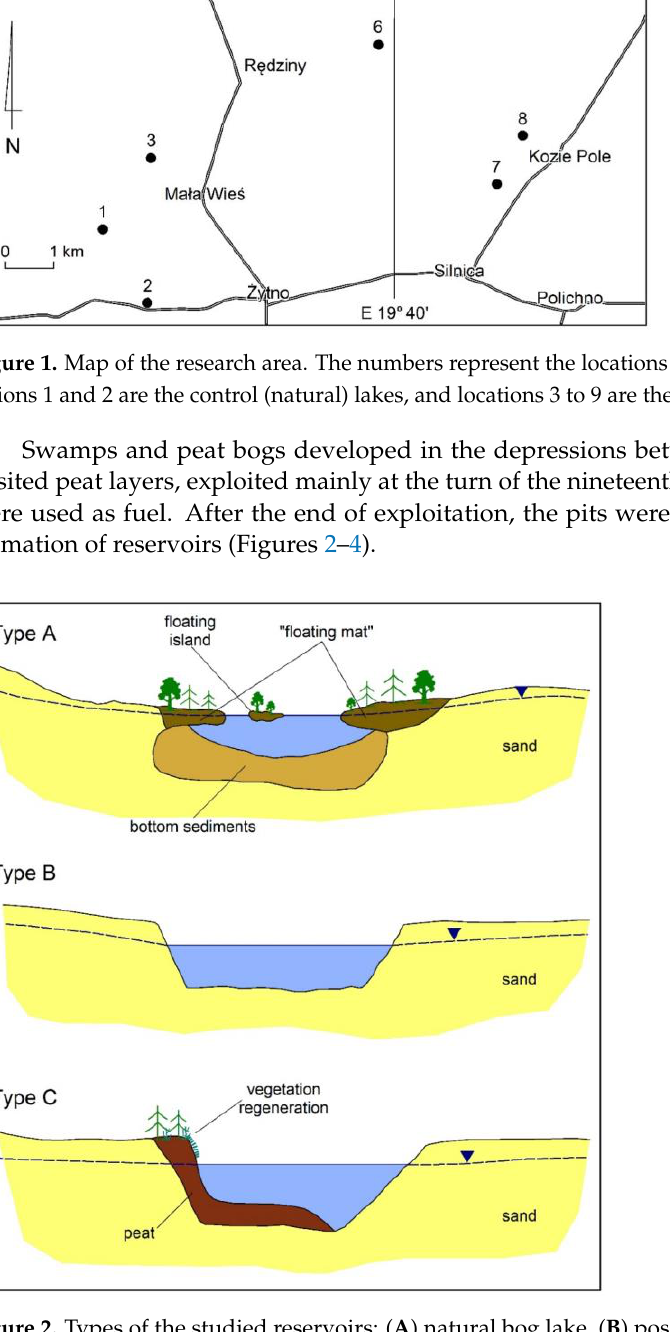
Figure 2. Types of the studied reservoirs: ( A ) natural bog lake, ( B ) post-exploitation peat reservoir, the basin of which is cut in mineral formations (sands), and ( C ) post-exploitation peat reservoir, the basin of which is partially cut in peat.